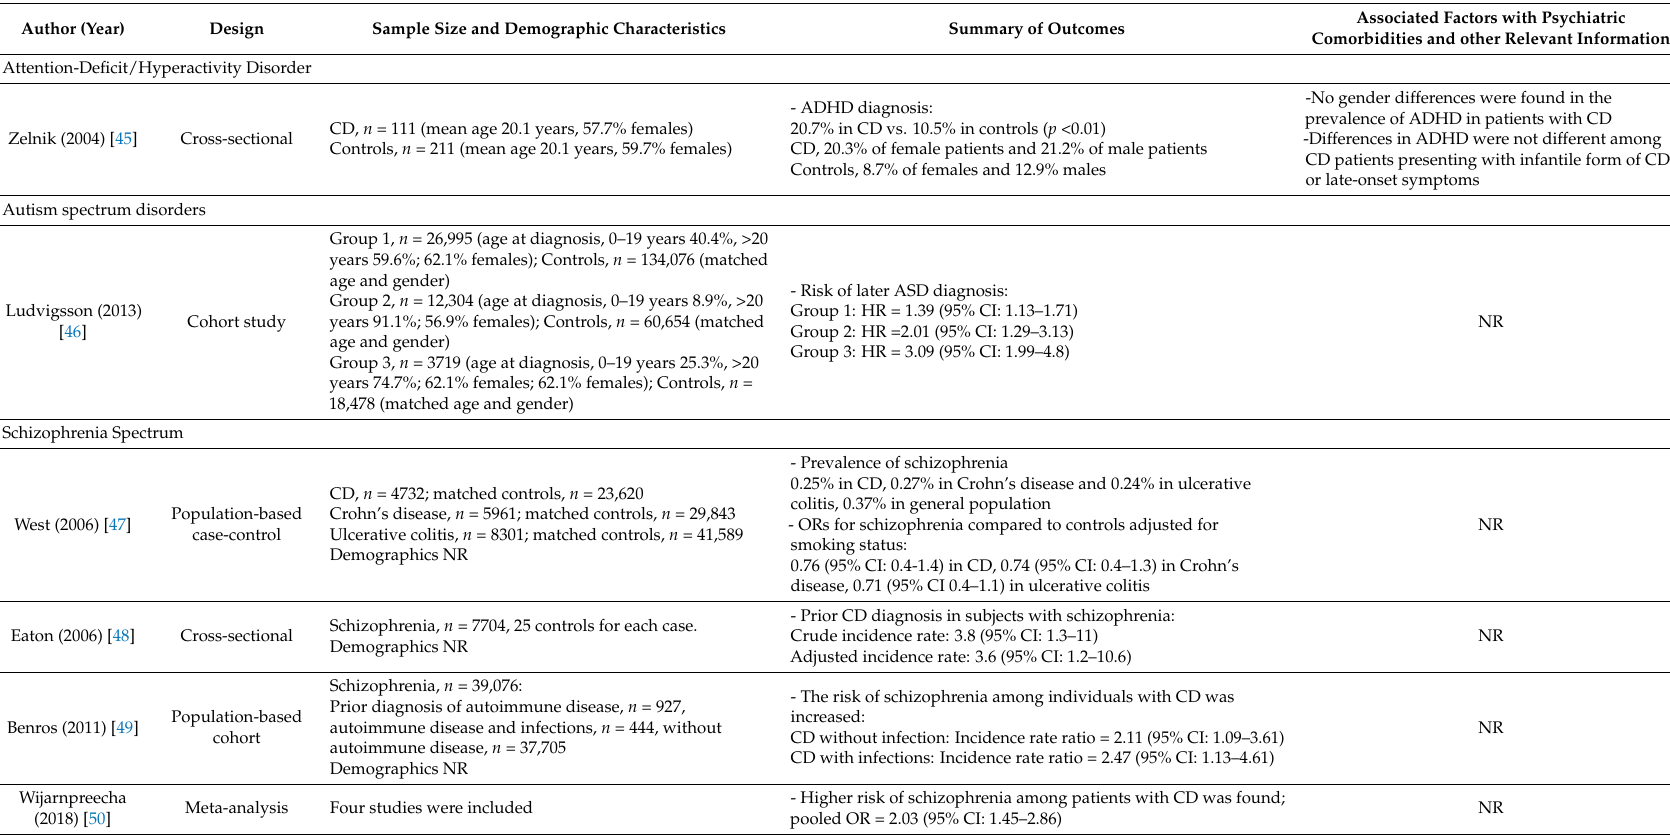
Table 4. Summary of outcomes evaluating the association between gluten-related disorders and psychiatric disorders in